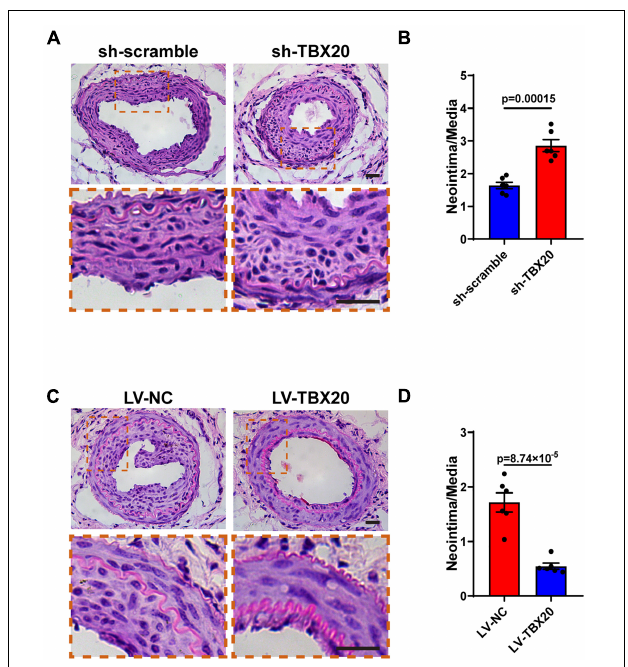
FIGURE 6 | Role of TBX20 in neointimal hyperplasia after vascular injury. (A,C) H&E staining of injured femoral arteries at 28 days post PVASCs transplantation. (B,D) Quantitative analysis of the area ratio of neointima to media. Scale bar = 50 µ m.